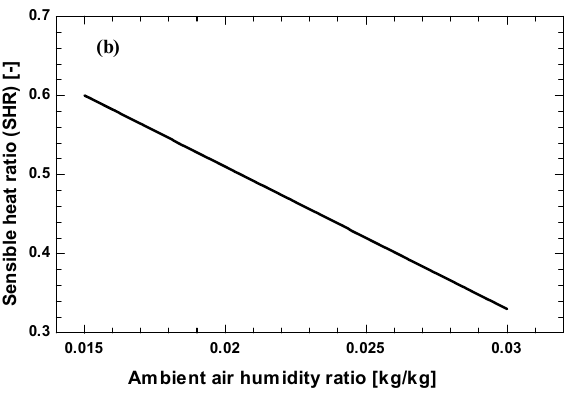
Figure 4. Effect of ambient air humidity ratio on ( a ) moisture removal rate ( M r ); ( b ) sensible heat ratio (SHR). The effect of ambient humidity ratio on the performance of the system is shown in Table 6. As discussed previously, the higher the ambient air humidity, the higher the CC of the system and the lower the thermal energy demand for the system. Therefore, the COP, ECOP and TCOP increase with increasing ambient air humidity ratio, as shown in Table 6. Table 6. Effect of ambient humidity ratio on the system performance. Ambient Humidity Ratio